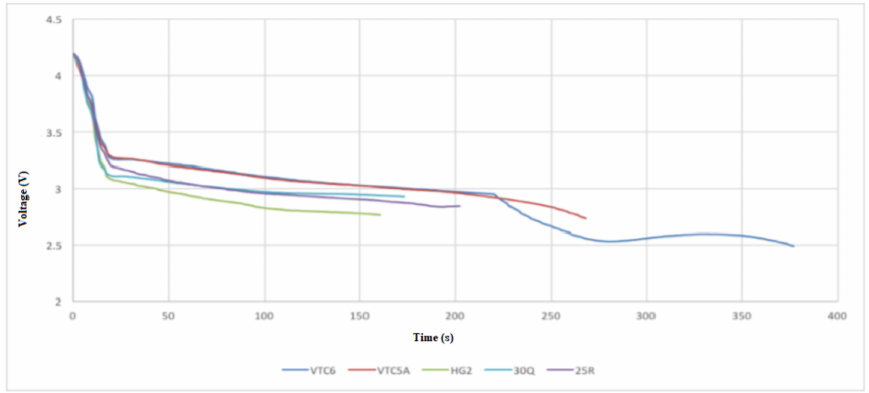
Figure 6. Single cell tests: voltages from 30 A discharge with no cooling.